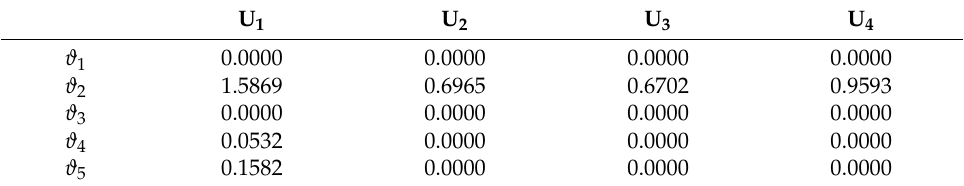
Table 7. The results of PDA ij